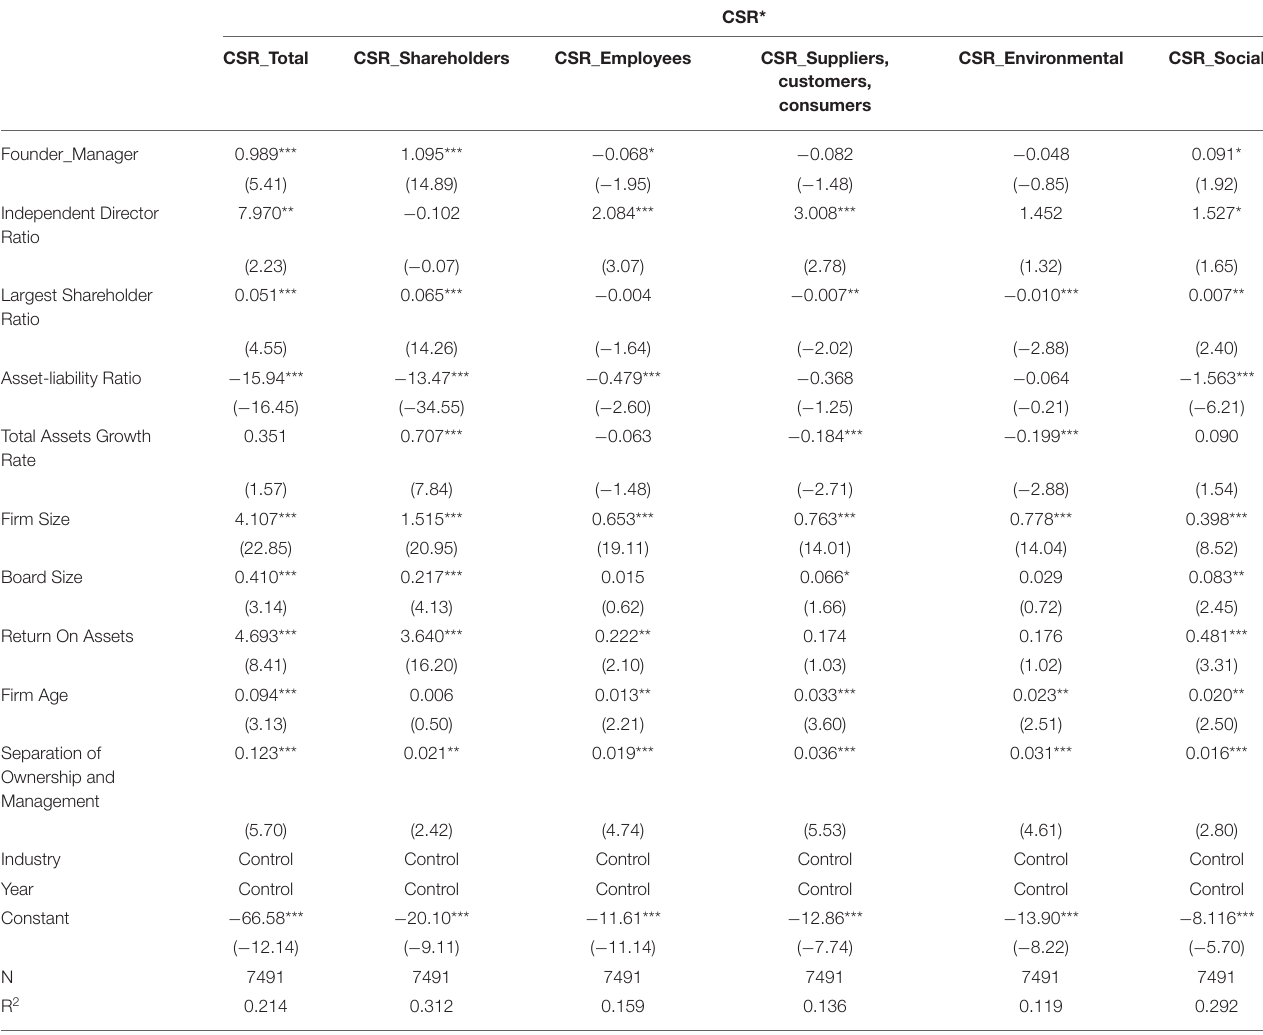
TABLE 12 | Regression results (founder’s management level and